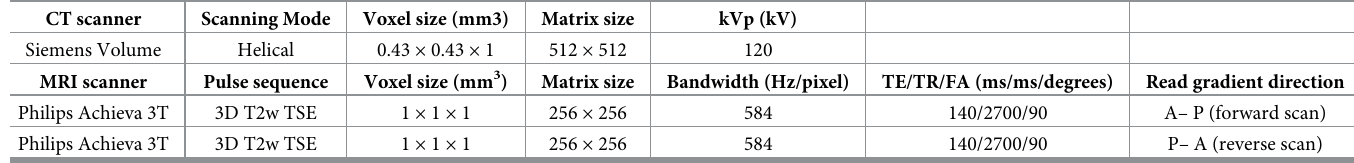
Table 1. CT and MRI acquisition parameters for the scans performed in this